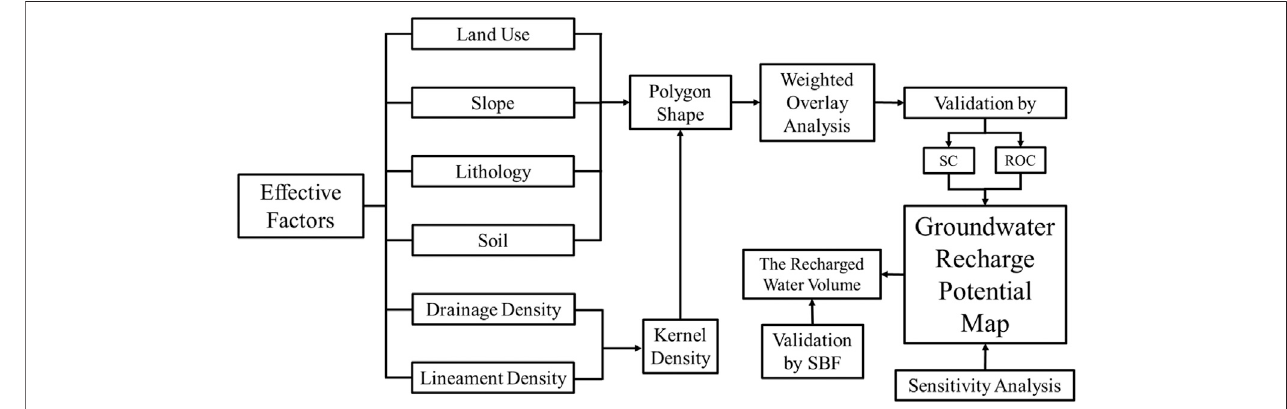
FIGURE 2 | Flowchart of GRP map processing including validation by SC, ROC and SBF